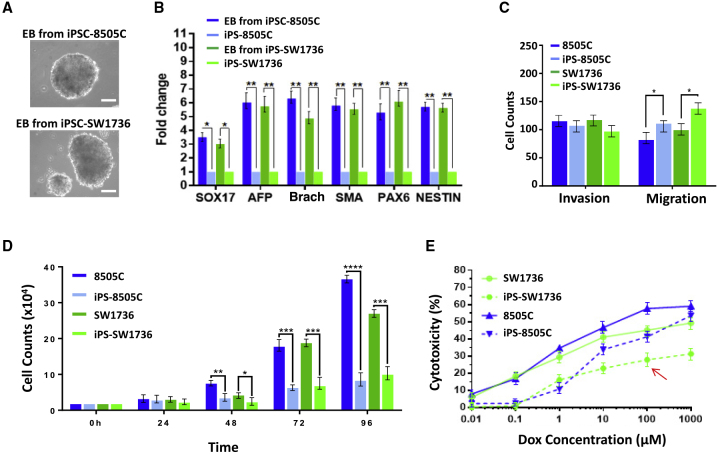
Properties and Differentiation Potential of the Cancer-Derived hiPSCs(A and B) Differentiation of hiPSCs into normal derivatives of all three germ layers within an epiblast “organoid” (also termed an embryoid body [EB]). (A) Phase photomicrograph of the EBs derived from iPS-8505C (upper panel) and from iPS-SW1736 (lower panel). Scale bars, 100 μm. (B) Gene expression levels of derivatives from the three fundamental germ layers which differentiated within EBs generated from the cancer-derived hiPSCs (iPS-8505C and iPS-SW1736) compared with the respective hiPSC in monolayer before EB formation (as measured by RT-PCR): endoderm markers SOX17 and AFP (alpha-fetoprotein); mesoderm markers BRACHYURY (BRACH) and SMA (α-smooth muscle actin); ectoderm markers PAX6 and NESTIN. See Figure S4 for immunostaining for these markers. The result was reproducible in three independent experiments.(C–E) Some characteristics of malignancy in iPS-8505C and iPS-SW1736 compared with their respective starting parental cancer cells (8505C and SW1736). (C) Cell migration and invasion assays showed that the migratory ability of the hiPSCs increased (typical for a stem cell) compared with their respective parental cancer cells but without an increase in their invasiveness. These experiments were repeated at least three times. (D) Assessing proliferation based on cell counts over time showed that proliferation of the hiPSCs was significantly decreased compared with that of their parental cancer cells. The experiment was repeated at least three times. (E) Sensitivity to classic chemotherapeutic drugs of the parental cancer cells compared with their respective reprogramed hiPSCs, using an MTT-based assay to distinguish between cytostatic and cytotoxic responses. The slowly proliferative cancer cell-derived hiPSCs (especially iPS-SW1736 [red arrow]) lost much of their sensitivity to doxorubicin (doses between 0.01 and 1,000 μM), another sign of loss of a malignant neoplastic phenotype. The data were collected from three independent experiments. Error bars indicate the standard error of the mean.Related to Figure S4